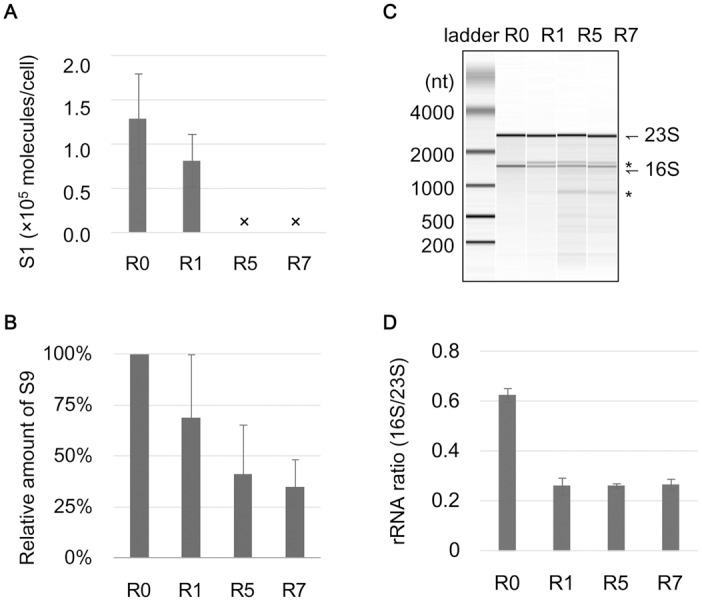
Damage in ribosomes.
A. The relative abundance of the ribosomal protein S1 in cells. The ribosomal protein S1 was detected by western blotting, and its relative abundance was calculated according to the band intensity by image analysis using the purified S1 protein as the positive control. Crosses indicate the disappearance of the band. The standard errors of three independent Western blot analyses are shown. B. The relative abundance of the ribosomal protein S9. The ribosomal protein S9 was detected by western blotting, and its relative abundance was calculated according to the band intensity by image analysis. Standard errors of triplicates are shown. C. Ribosomal RNAs. An example RNA electrophoresis pattern of the total RNAs is shown. 16S and 23S rRNAs are indicated. The truncated rRNAs are indicated with asterisks. D. The ratio of 16S and 23S rRNAs. The ratios of 16S and 23S rRNAs were calculated according to the band intensity and area as shown in C. Standard errors of the RNA samples purified from three independent cell cultures are indicated.